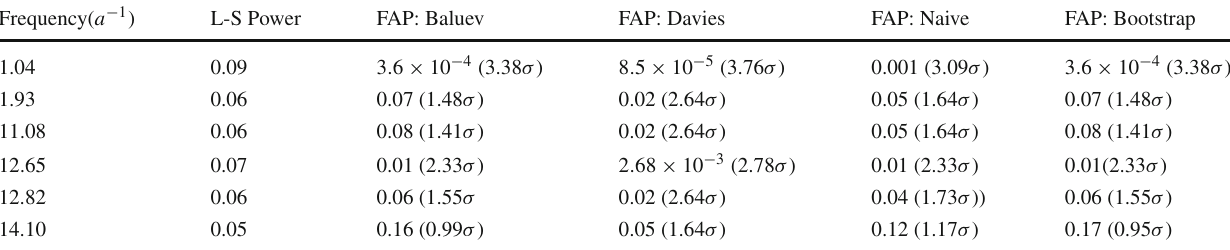
Table 1 L–S powers and FAP for BNL data using multiple methods: Baluev, Davies, Naive, Bootstrap methods, for only those frequencies for which the power is greater than 0.05. The numbers in parenthesis represent the Z-score, found using the method prescribed in Ref. [32].